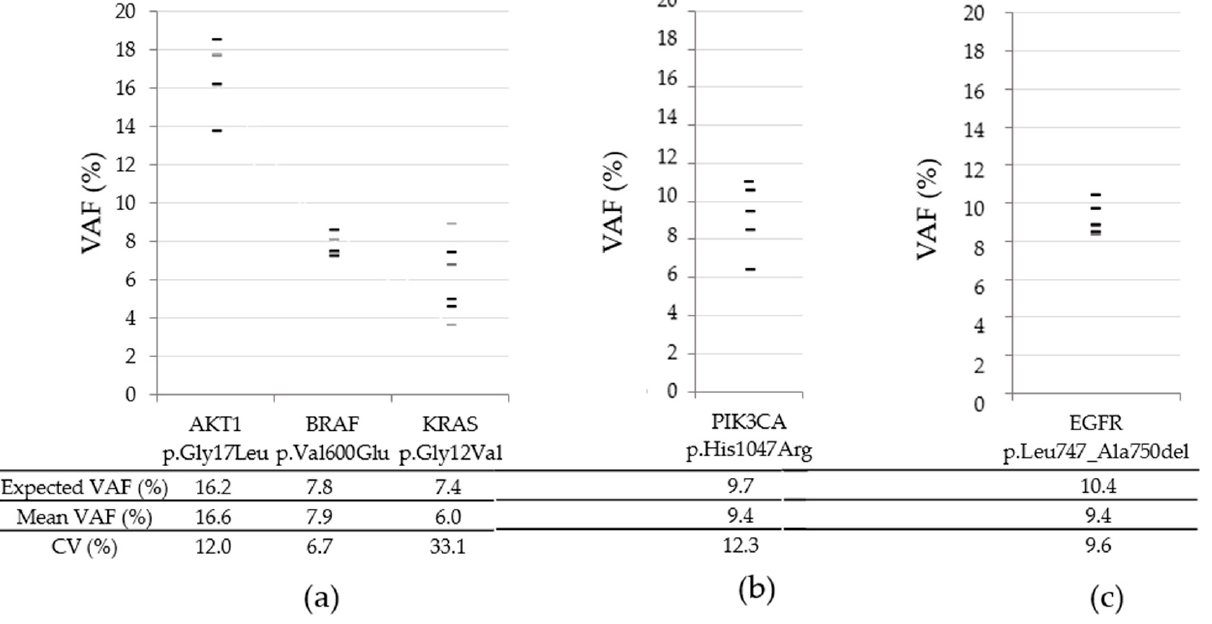
Figure 3. Inter-run variability of variant quantification in clinical samples. ( a ) colorectal tissue; ( b ) and ( c ) lung tissues. Expected VAF were determined using THS assay ( n = 1); mean VAF were de- termined using OFA ( n = 6).